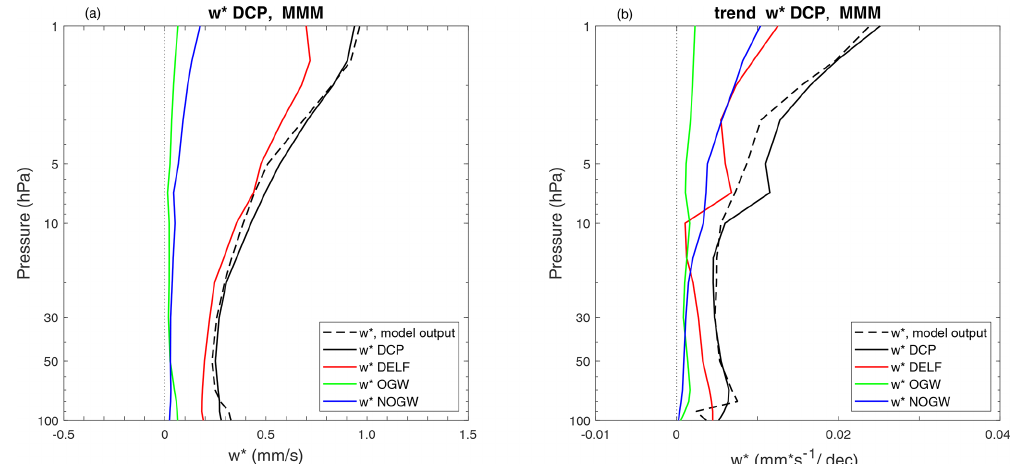
Figure 11. Climatology (a) and trends (b) of wave forcing of the residual circulation for the MMM, computed over the 150 years of the 1pctCO2 simulations. Dashed line: tropical upwelling provided as model output; solid black line: total upwelling from downward control principle (DCP); red line: upwelling due to resolved waves, computed from the Eliassen–Palm flux divergence (DELF); green line: upwelling due to orographic gravity waves (OGWs); and blue line: upwelling due to non-orographic gravity waves (NOGWs). Note that the GISS model is not included, because the NOGW output was not available.